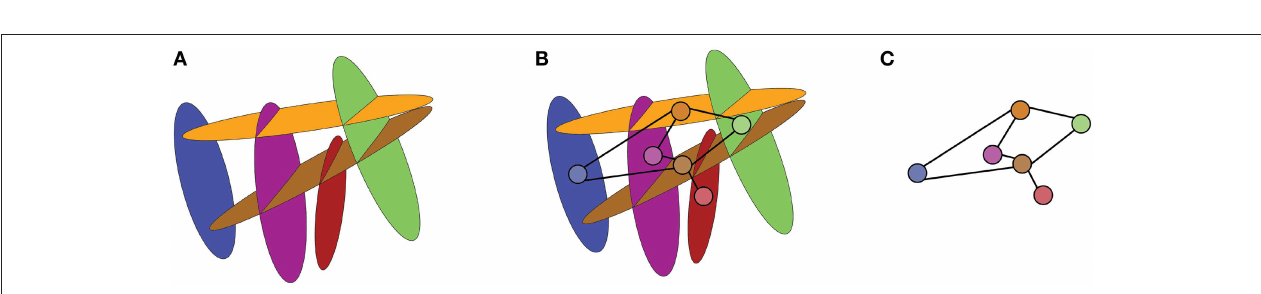
Frontiers in Physics |